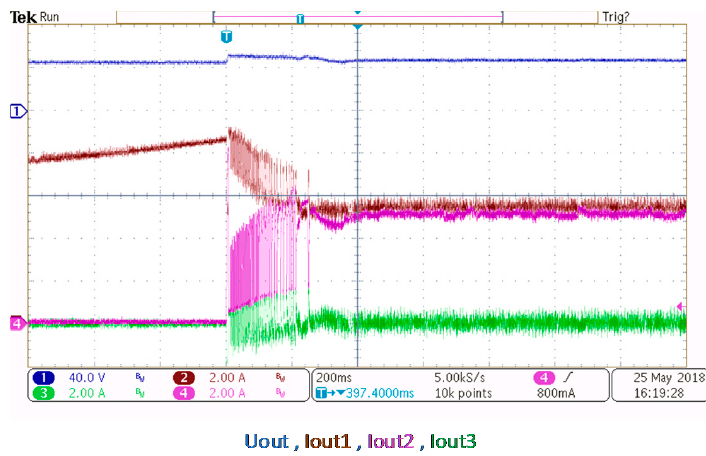
Figure 14. Experimental results from sequential switching of MASTER-voltage SLAVE-current control strategy ( P OUT = 25% to 35%) .